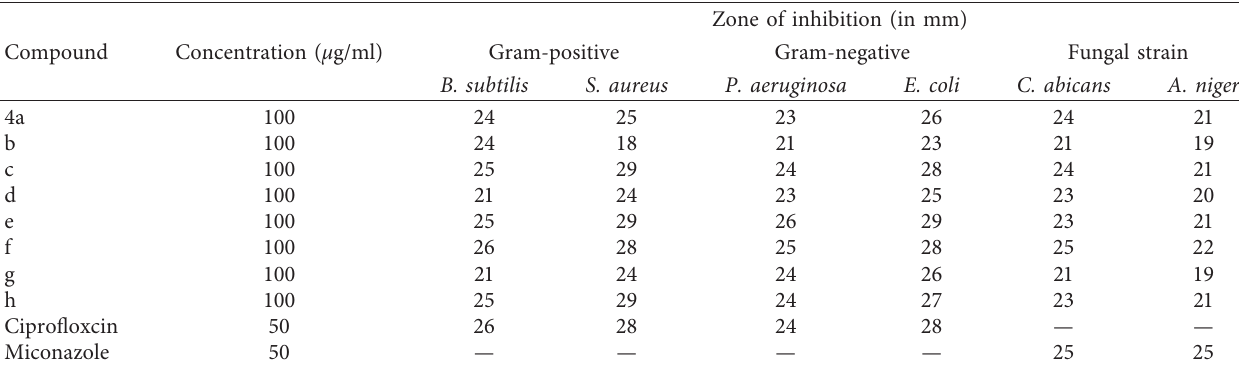
Table 2: Antimicrobial activity data of compounds from 4a-h